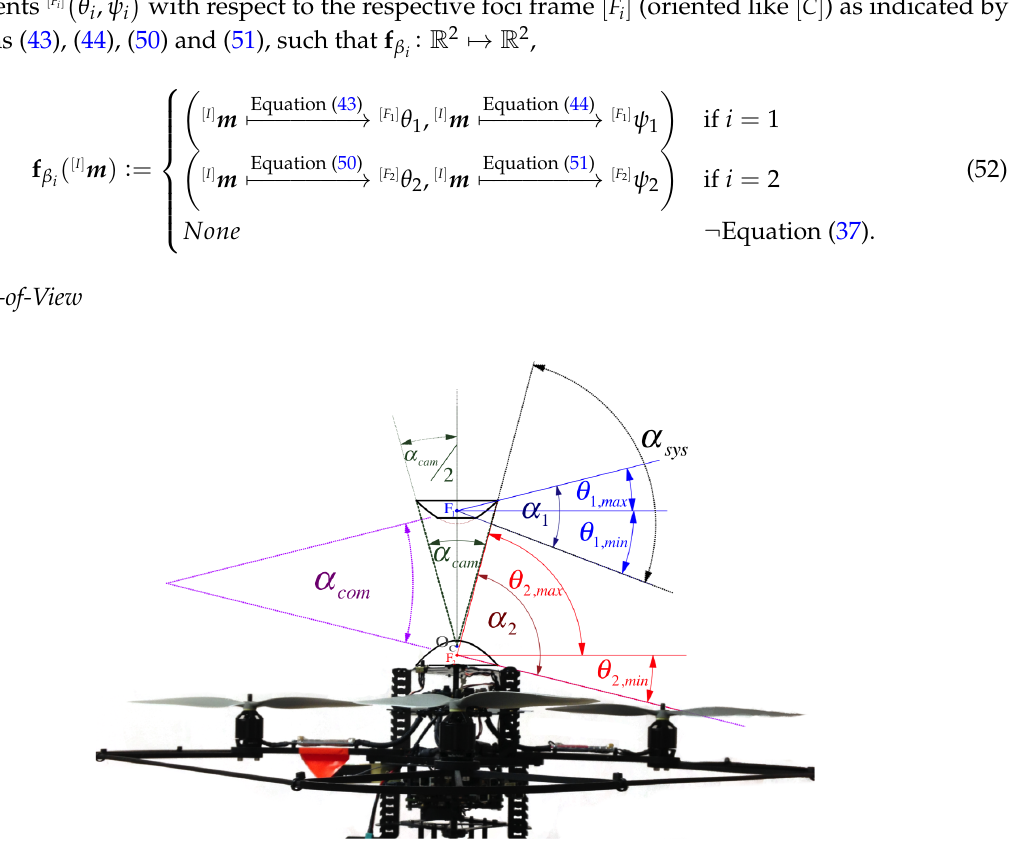
Figure 5. Vertical Field of View (vFOV) angles: α 1 and α 2 are the individual angles of the mirrors formed by their respective elevation limits θ 1/2, min / max ; α sys is the overall vFOV angle of the system; and α SROI measures the overlapping region conceived between α 1 and α 2